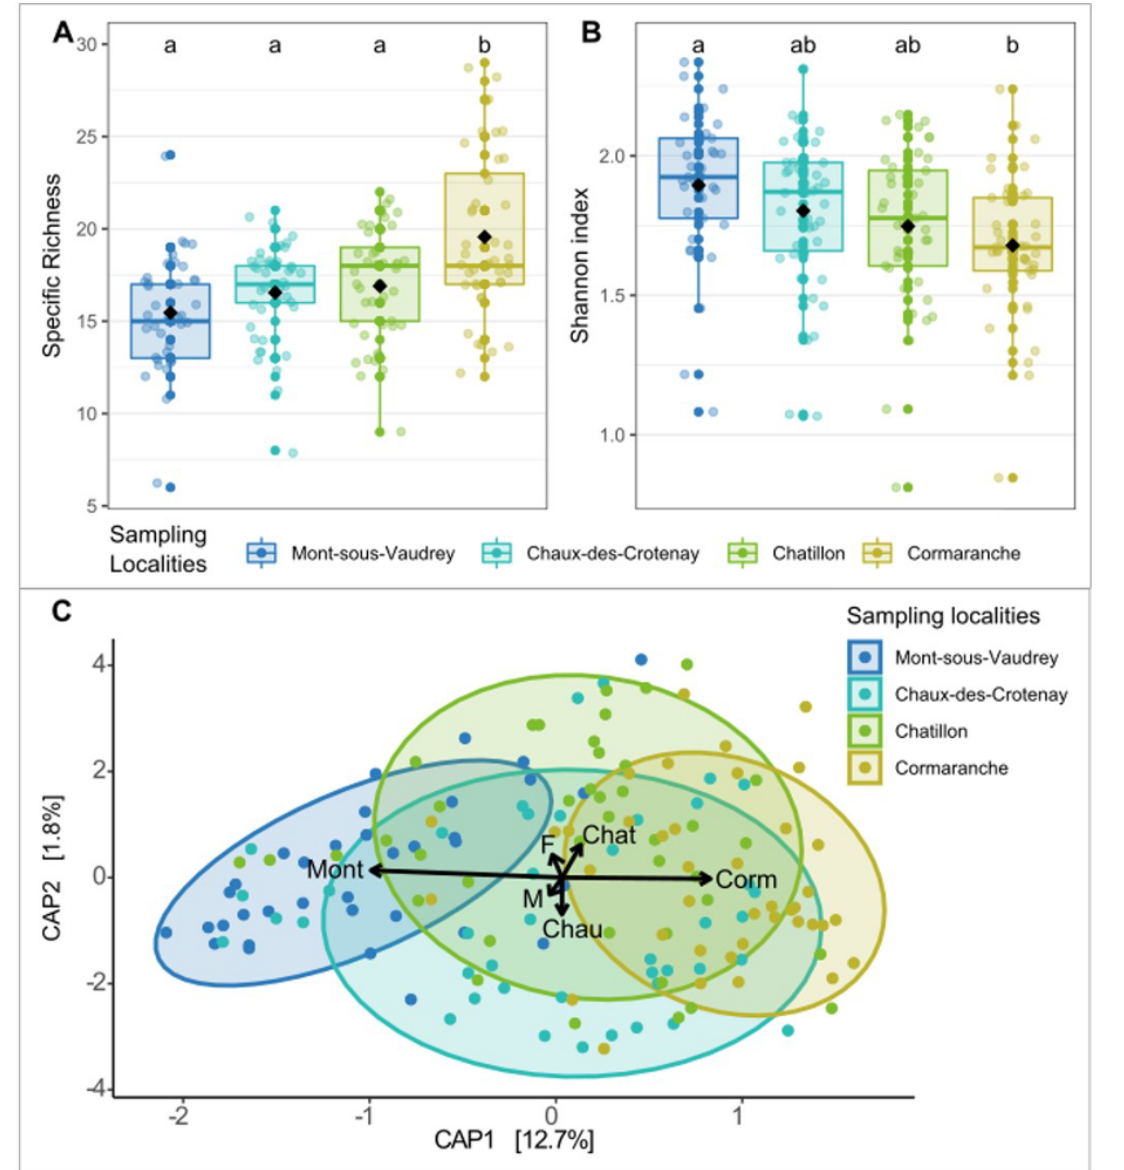
Figure 2- Variations of the gut bacteriota alpha diversity between localities. Alpha diversity is represented using A) the specific richness of the gut bacteriota, and B) the Shannon index of the gut bacteriota, Results are shown per locality, ordered from North to South. Each colored point represents an individual. Black points indicate the average alpha diversity per locality. Box-and-whisker plots represent the median and interquartile values. Different letters denote statistically significant differences at P < 0.05, with pairwise post-hoc Tukey adjustments. C) Distance-based redundancy analysis (db- RDA) of the gut bacteriota (family) based on Bray–Curtis dissimilarities. Dots represent individuals. The colors and shapes of the dots are associated with different factors: Localities from North to South (Mont-sous-Vaudrey: Mont, Chaux-des- Crotenay: Chau, Chatillon: Chat and Cormaranche: Corm) and gender (females: F and males: M). Significative factors based on the ordiR2step analysis are shown as arrows. Ellipses represent a 80% confidence interval around the centroid of the clusters, for each